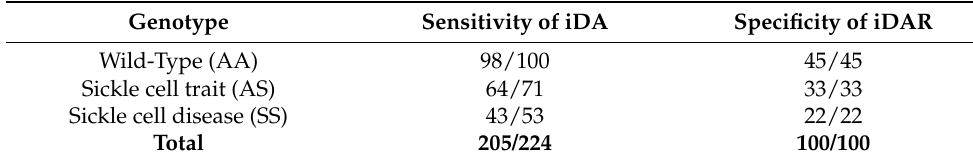
Table 3. Sensitivity and specificity of the iDAR assay.